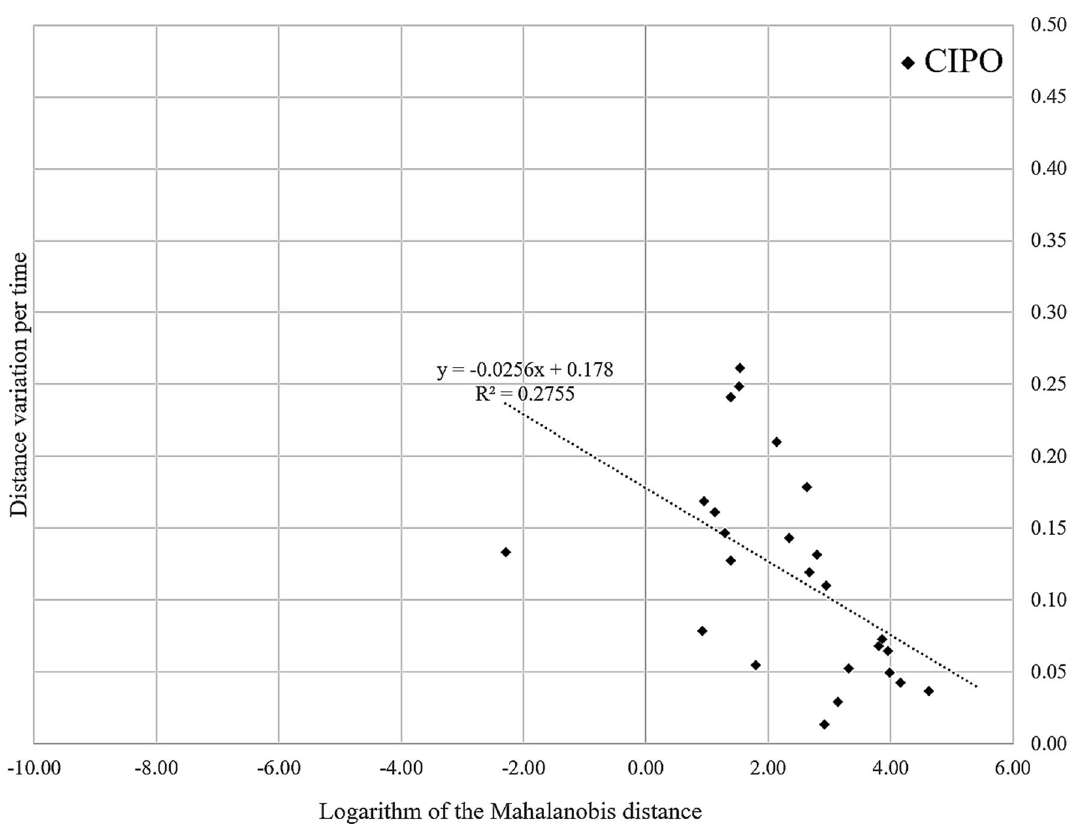
Figure 10. In patients with chronic intestinal obstruction, the logarithm of the Mahalanobis distance and distance variation per time were inversely